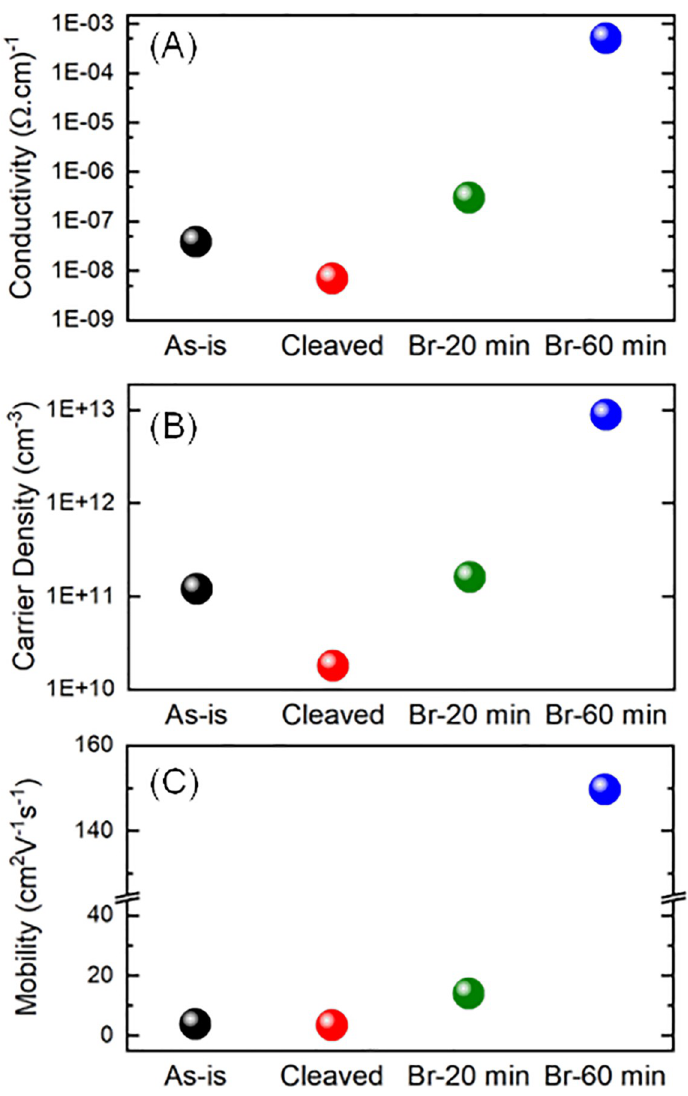
‘Br-20 min’ and ‘Br-60 min’ represent 20-min and 60-min bromine-treated samples, respectively. Values are averages over 4–5 crystals (see S3 Table for